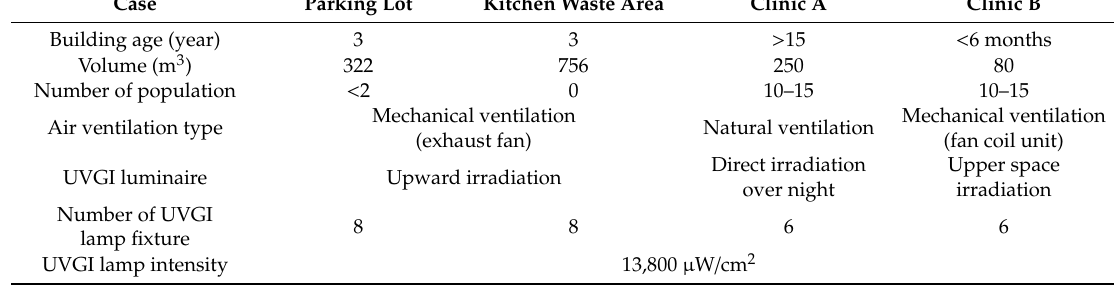
Table 1. Details of building information and UVGI application for field studies.